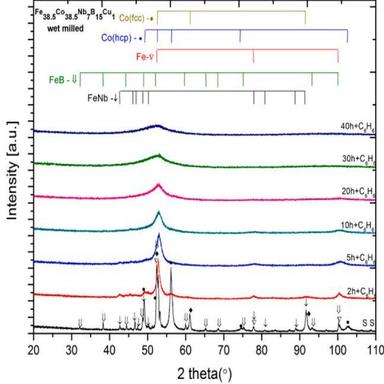
X-ray diffraction patterns at room temperature of the starting sample (noted SS) and of the Fe38.5Co38.5Nb7B15Cu1 wet-milled samples up to 40 h. For clarity, the XRD patterns have been shifted vertically.